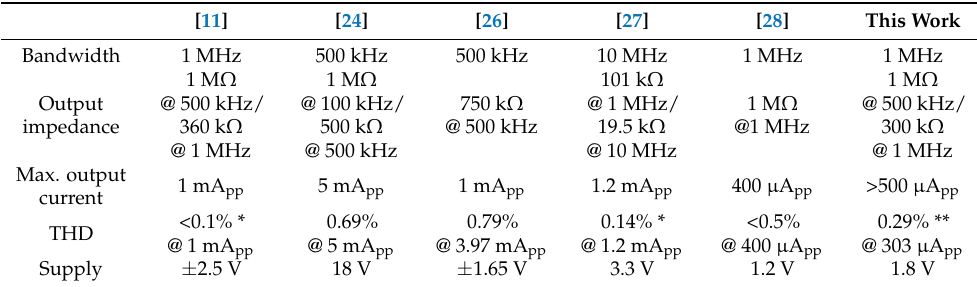
Table 3. Comparison of the current